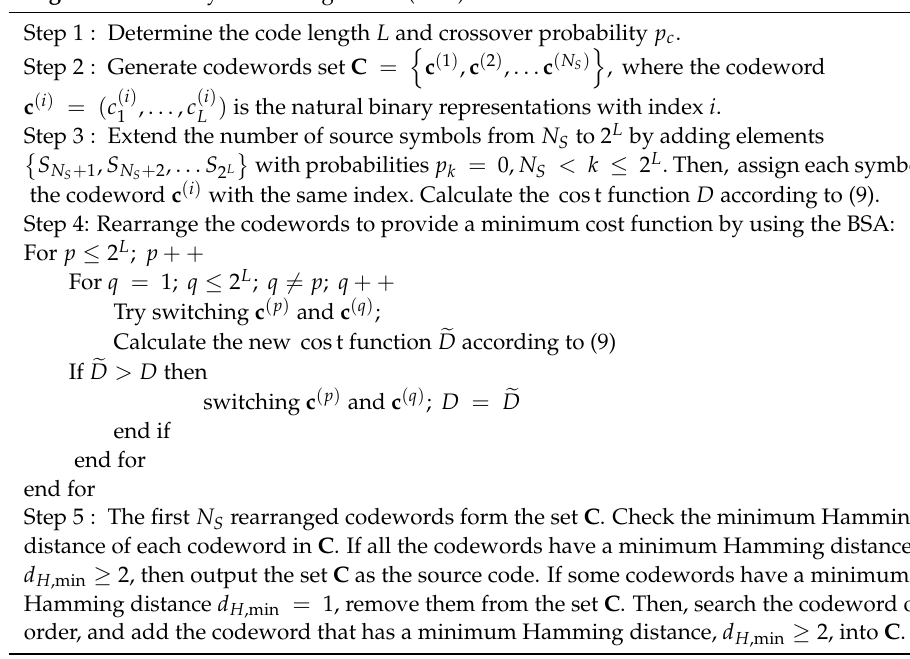
Algorithm 1 Binary Switch Algorithm